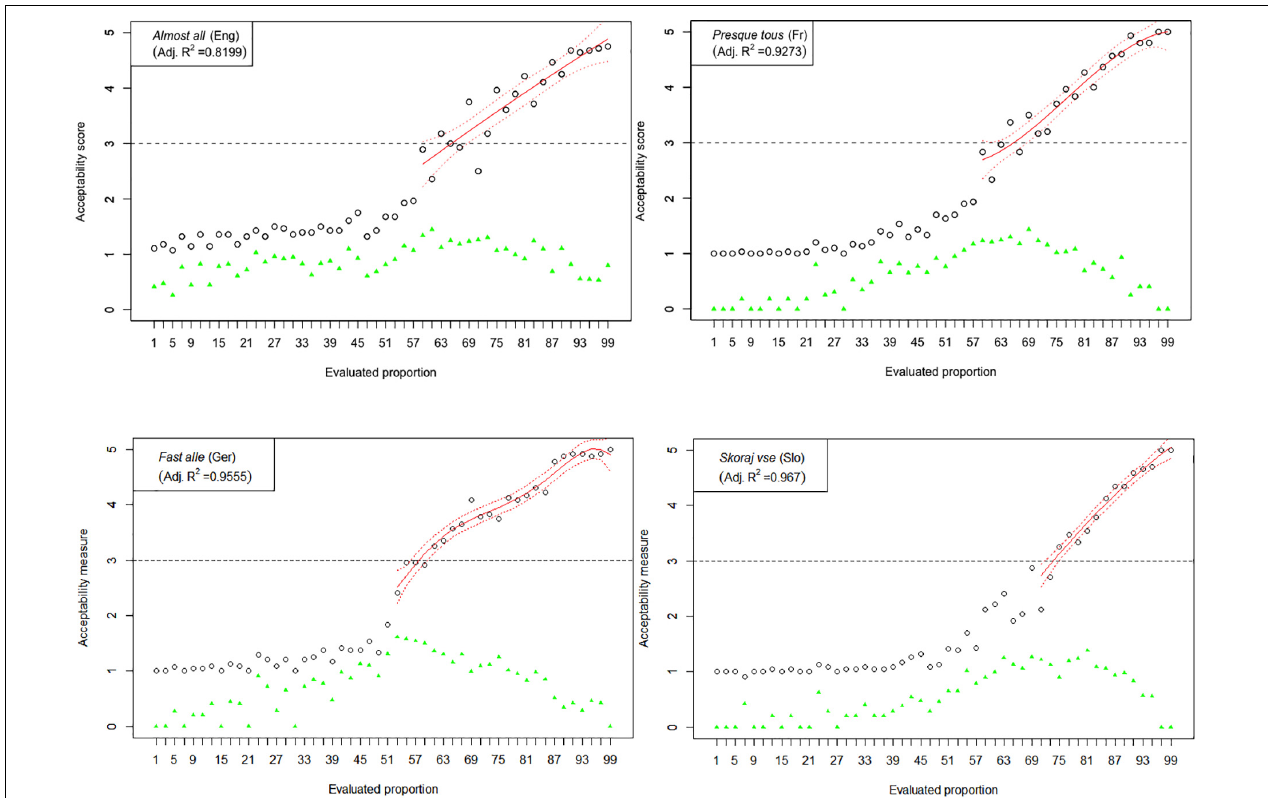
FIGURE 6 | Experiment 1: Mean acceptability scores on almost all and its cross-linguistic variants in the four tested languages (absolute values of standard deviation for respective means are shown in green), together with respective polynomial fit curves and confidence intervals predicting acceptability in the upper half of the Likert